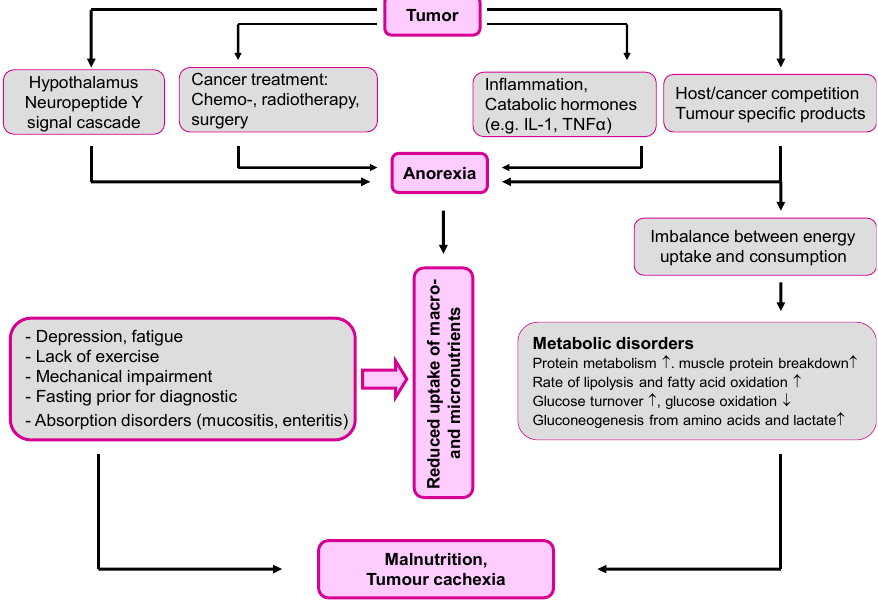
Figure 1. Causes of macro- and micronutrient deficiencies in cancer.